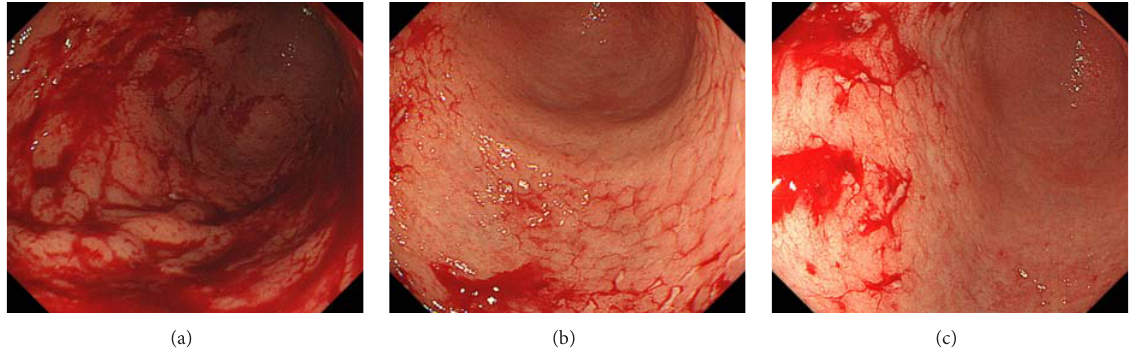
Figure 5: Esophagogastroduodenoscopy performed eight years after the initial diagnosis. Spontaneous bleeding from the gastric mucosa was